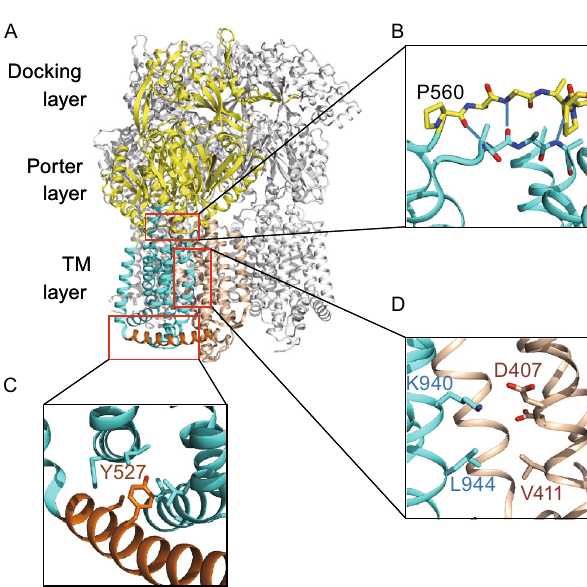
Figure 1. AcrB structure and mutation sites . (A) Trimer crystal structure of E . coli AcrB (PDB ID: 4DX5). One protomer is shown in color, and the other two in grey. The N TM and C TM subdomains are shown in wheat color and cyan, respectively. The porter domain and docking domain are in yellow. The cytosolic-side amphipathic helix, α 6-7, is colored in orange. (B) The signaling motif-C in C TM . The three main-chain H-bonds are depicted as dash-lines. Except proline residues, side-chains are omitted for clarity. (C) The α 6-7 region. (D) Region of the titratable key